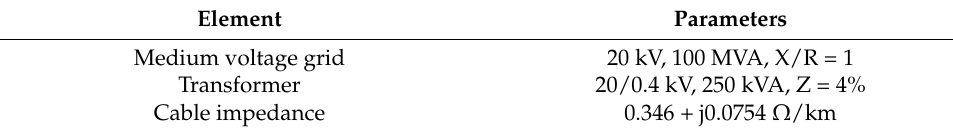
Table 2. Optimized droop setting according to